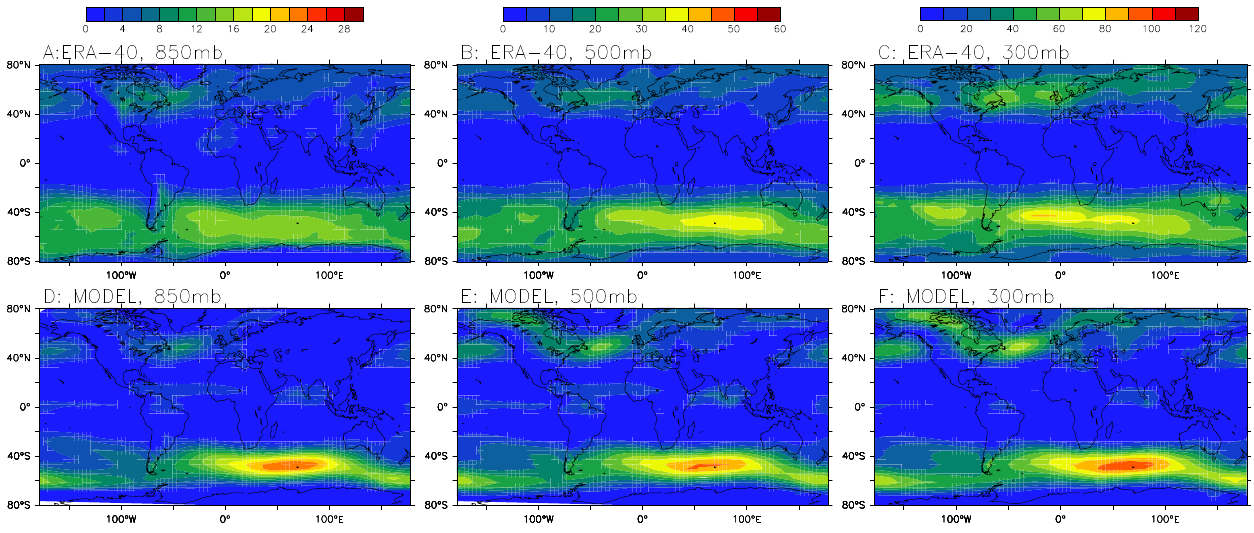
i (in m 2 s − 2 ) for June-July-August. (d–f) show the k